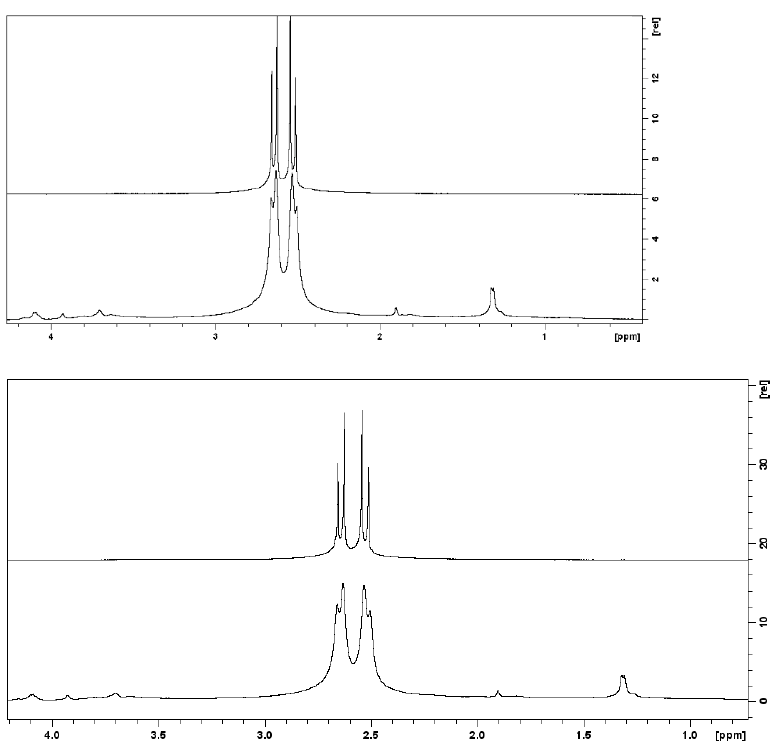
Figure 6. Comparison between 1D NMR spectra recorded with the sequence noesypr1d on water